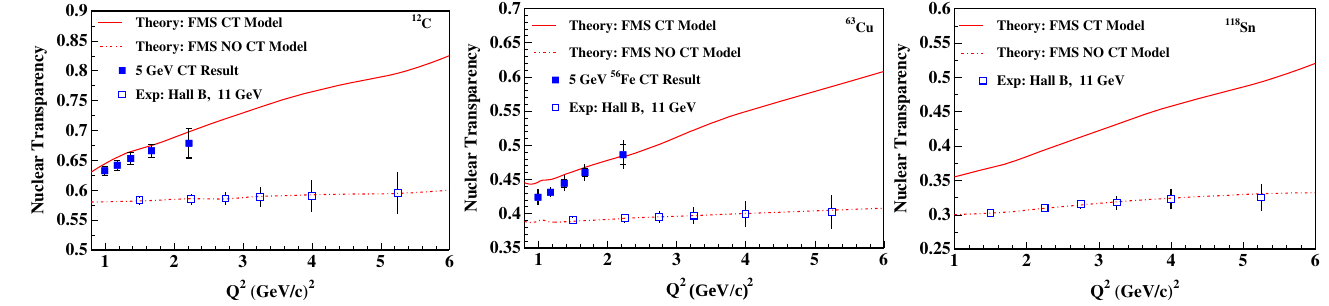
Figure 5. The CLAS12 projections (open squares) for 12 C ( right ), 63 Cu ( middle ), and 118 Sn ( left ) for the lowest l c bin plotted randomly on the FMS NO CT curve (dashed-dotted line) as their magnitude will be measured in this study. It also includes the 5 GeV 12 C and 56 Fe CT results (solid squares) [40] along with the FMS [46] model, which successfully described our 5 GeV CT results, and its 11 GeV predictions are tailored to our